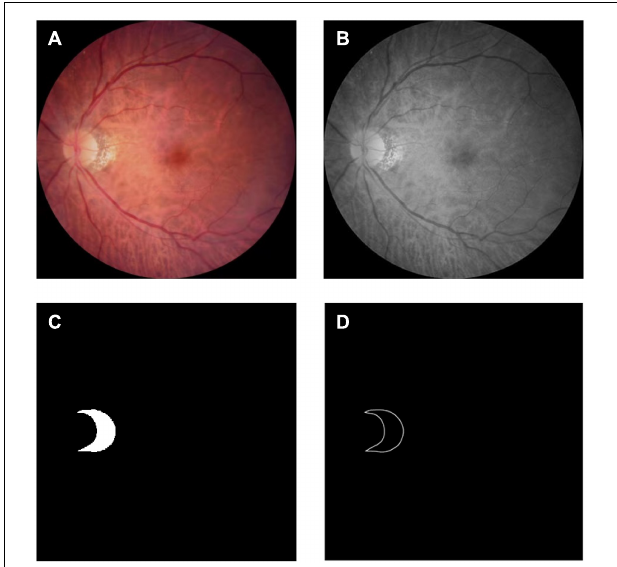
FIGURE 3 | Dataset: (A) color photo of the fundus of high myopia: Obtained using Topcon TRC-NW300 non-mydriatic fundus camera; (B) grayscale image of the fundus of high myopia: Apply Adobe PhotoShop 2019 to grayscale images; (C) gorund truth mask of the parapapillary atrophy: Obtained by labeling the grayscale image using labelme; (D) edge map of the parapapillary atrophy: Obtained by processing the real label image using Adobe Illustrator